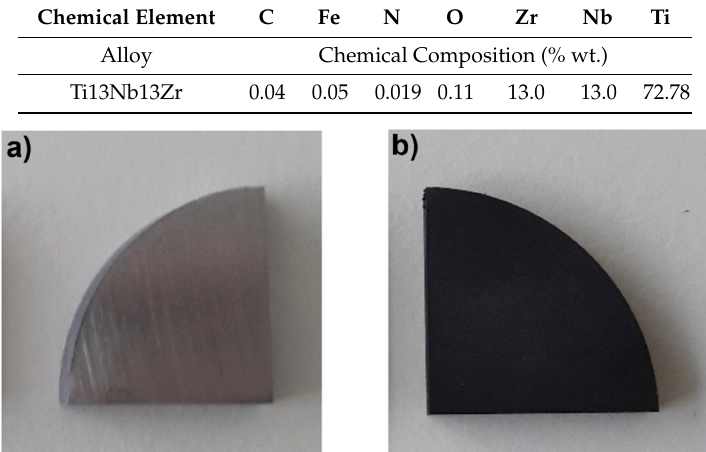
Table 1. Chemical composition of Ti13Nb13Zr titanium alloy in % by weight.